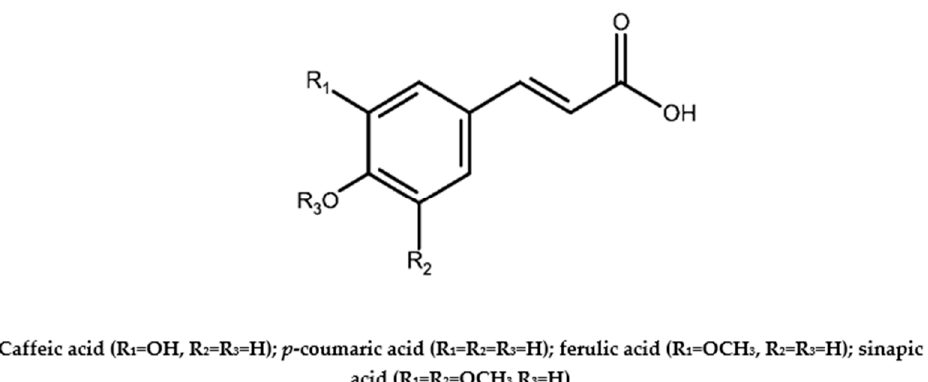
Figure 1. Chemical structure of kaempferol and commonly detected glycosides (adapted from [27]). Laurel leaves contain a variety of biologically active kaempferol glycosides formed kaempferol-3-O-glucoside (astragalin), kaempferol-3-O-rutinoside and kaempferol-3-O- α -L-(2 ′′ ,4 ′′ -di-E- p -coumaroyl)-pyranorhamnoside [13,14].